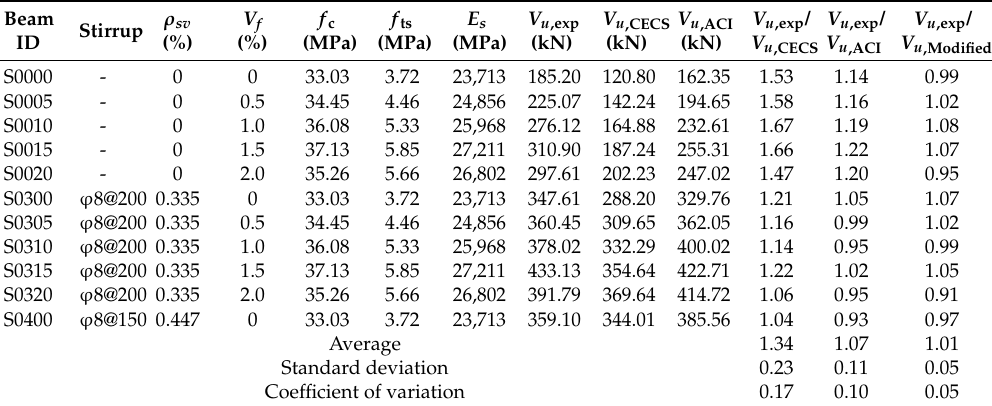
Figure 2. Dimension and reinforcement details of the experimental beams (Dimension in mm). ( a ) The specimens without stirrups; ( b ) The specimens with stirrup ratio 0.335%; ( c ) The specimen with stirrup ratio 0.447%. Table 3. Major details of the experimental beams.